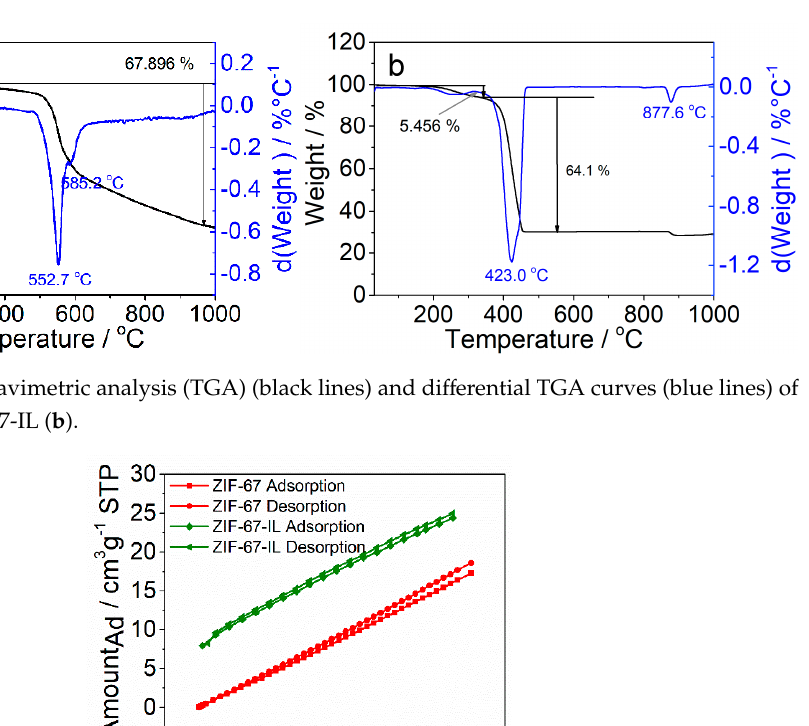
Figure 6. Thermogravimetric analysis (TGA) (black lines) and differential TGA curves (blue lines) of ZIF-67 ( a ) and ZIF-67-IL ( b ).